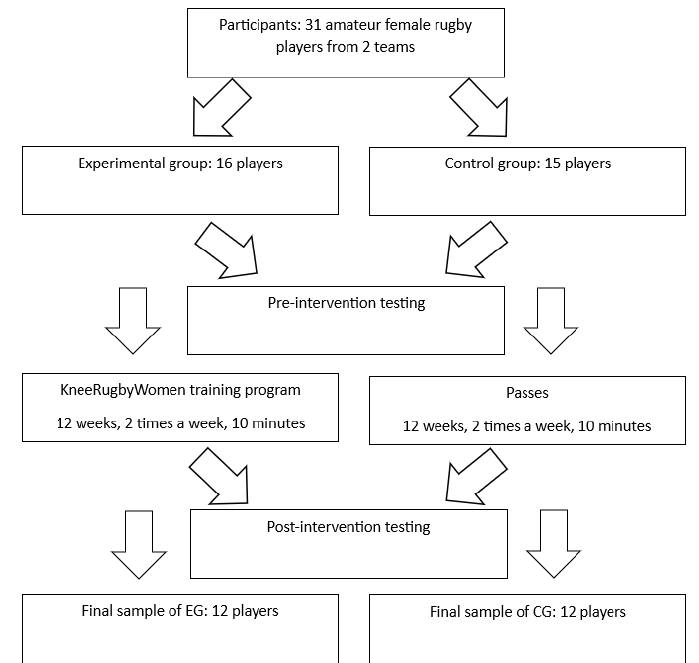
Figure 1. Study flow chart.